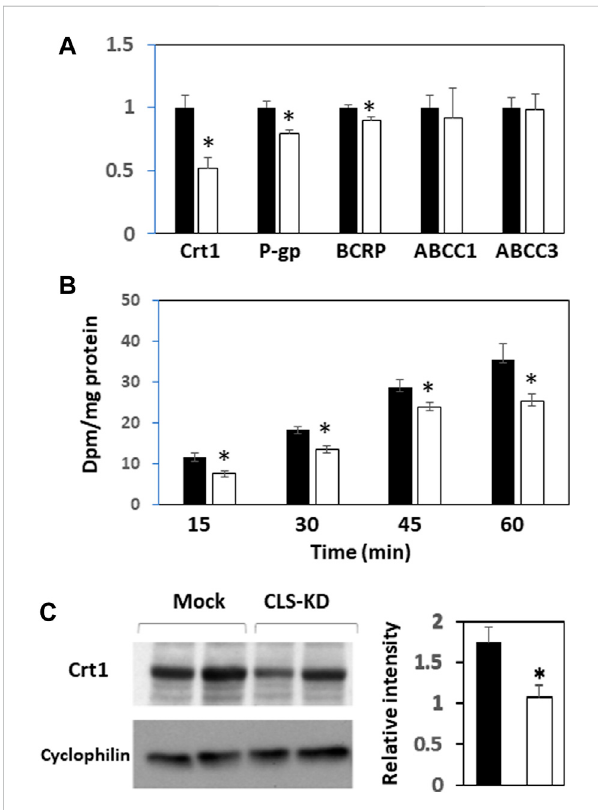
FIGURE 3 Expression of Crt1, P-gp, BCRP, ABCC1, and ABCC3, and ( 14 C) creatine uptake, and Crt1 protein expression in hCMEC/D3 cells transfected with hCLS1 siRNA. hCMEC/D3 cells were mock transfected (closed bars) or transfected with hCLS1 siRNA (open bars) for 48 h and Crt1, P-gp, BCRP, ABCC1, and ABCC3 mRNA expression (A) ,( 14 C)creatineuptake (B) andCrt1 proteinexpression (C) determined as described in Materials and Methods. n = 3 − 4, * p <